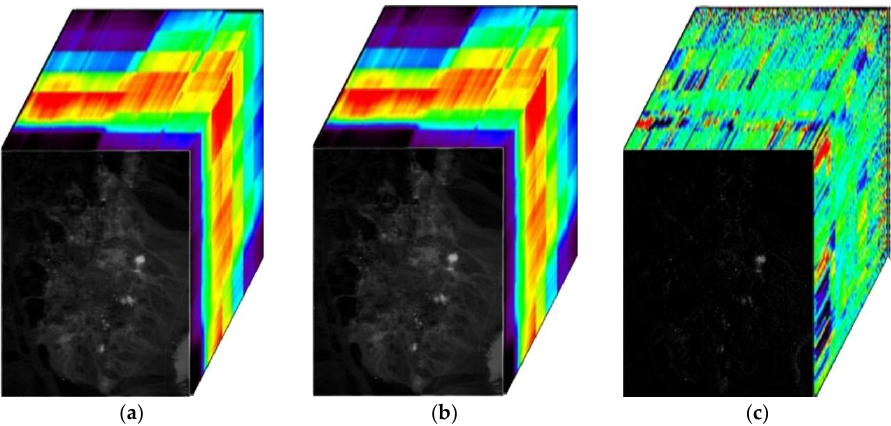
Figure 7. The synthetic dataset: ( a ) original imagery X ; ( b ) PC part X (cid:48) ; and ( c ) residual part E